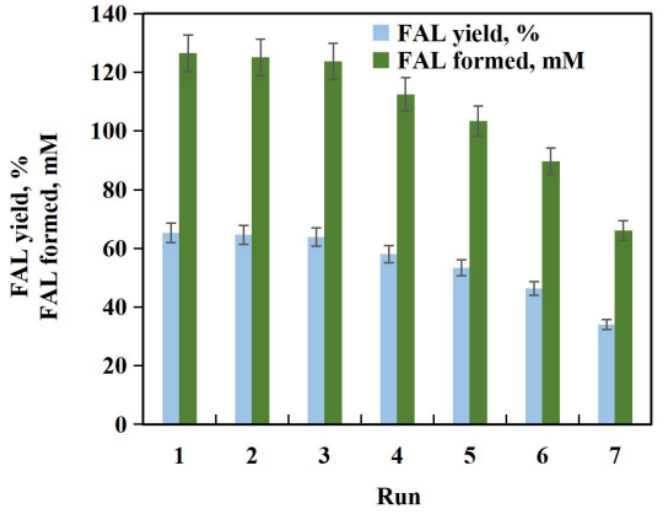
Figure 3. Recyclability of DES and heterogeneous catalyst. (40 mL ChCl:LA–water, 3 g corncob, hy-